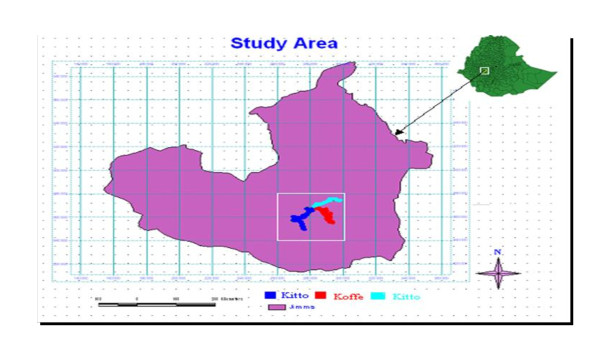
Map of the study area. The figure shows that Ethiopia and study area, Jimma town where Parasitological survey took place for this study.